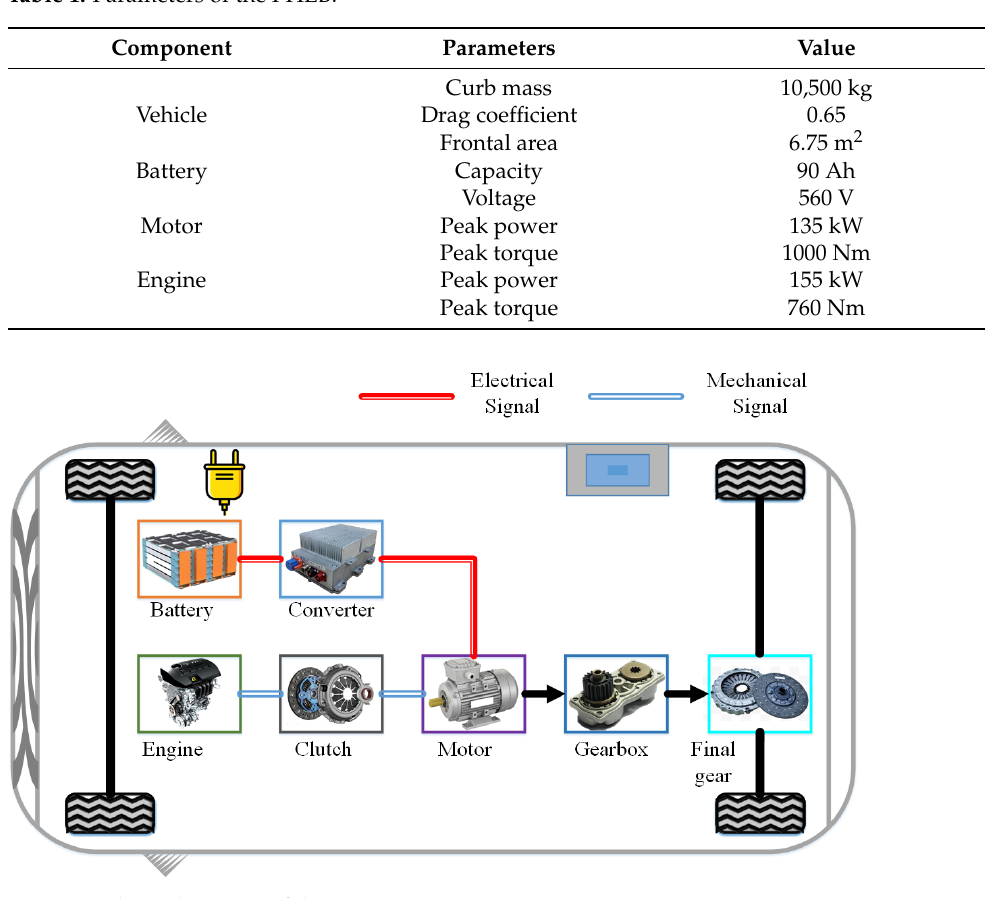
Figure 1. The architecture of the PHEB